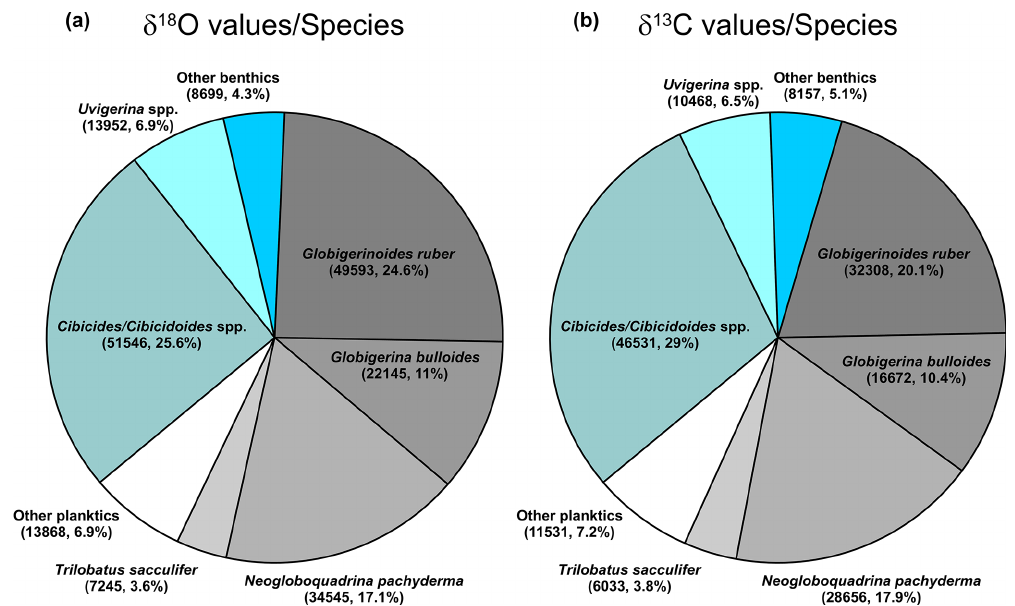
Figure 5. Fraction of oxygen (a) and carbon (b) isotope values measured on benthic (blue) and planktic (grey) species/species groups. Numbers below the species/genus names indicate absolute number of values and percentage from the total number of δ 18 O (a) or δ 13 C (b) values in the atlas. See Sect. S4 in the Supplement for the categorization of the individual species names from the original publications.